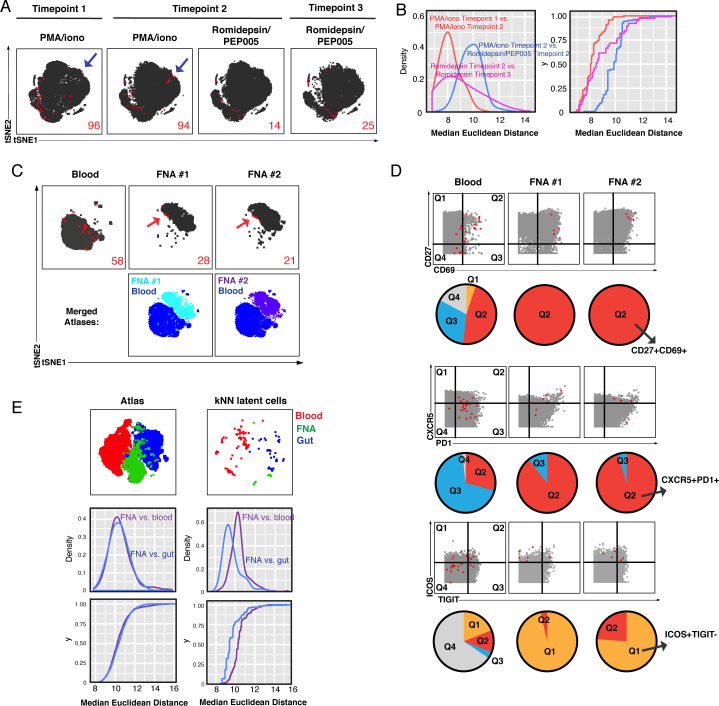
Comparison of kNN latent cells reactivatable by different stimulations and from blood versus tissues using longitudinal specimens.(A) Atlas (gray) and kNN latent cells (red) from three blood specimens from the same donor (PID5003) spaced 2–3 months apart, where reactivation was induced by either PMA/ionomycin or Romidepsin/PEP005. Arrows highlight regions that harbor kNN latent cells in the PMA/ionomycin but not Romidepsin/PEP005 samples. Red numbers indicate the number of kNN latent cells in each plot. (B) kNN latent cells reactivatable by PMA/ionomycin at two different time points are more similar to each other than to those reactivatable by Romidepsin/PEP005 at the same time point. The empirical cumulative distribution of median distances between kNN cells was calculated between (1) Time point 1 PMA/ionomycin and Time point 2 PMA/ionomycin samples (red), and (2) Time point 2 Romidepsin/PEP005 and Time point 3 Romidepsin/PEP005 samples (pink), and (3) Time point 2 PMA/ionomycin and Time point 2 Romidepsin/PEP005 samples (blue). (C) Atlases of memory CD4+ T cells from fine needle aspirates (FNAs) or the blood of the same donor (PID3010) with corresponding kNN latent cells (red). Red arrows point to regions of the FNA tSNEs that are concentrated in kNN latent cells. Bottom plots show each FNA atlas overlaid onto the blood atlas. Red numbers indicate the number of kNN latent cells in each plot. (D) Dot plots demonstrating that FNA but not blood kNN latent cells (red dots) express uniformly high levels of CD27, CD69, CXCR5, PD1, and ICOS. Atlas cells are in gray. Pie charts show proportions of kNN latent cells within each quadrant. (E) kNN latent cells from different tissue sites are similar. Top: Atlas (left) and kNN latent cells (right) from four blood, two FNA, and four gut specimens as depicted by tSNE. Middle/Bottom: Empirical cumulative distribution of median distances between atlas (left) or kNN cells (right), as calculated between FNA versus blood (purple) or versus gut (blue).